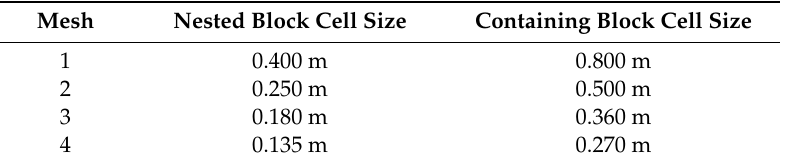
Table 1. Characteristics of the meshes tested in the convergence analysis.